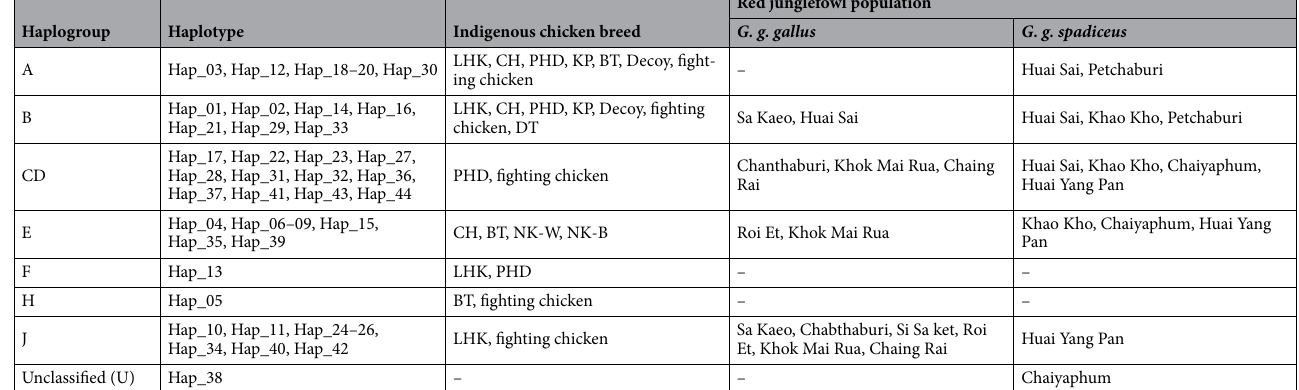
Table 2. Summary of haplogroups of mtDNA D-loop sequences and haplotypes that were found in 10 indigenous chicken breeds and 12 populations of two Gallus gallus subspecies in Thailand and their